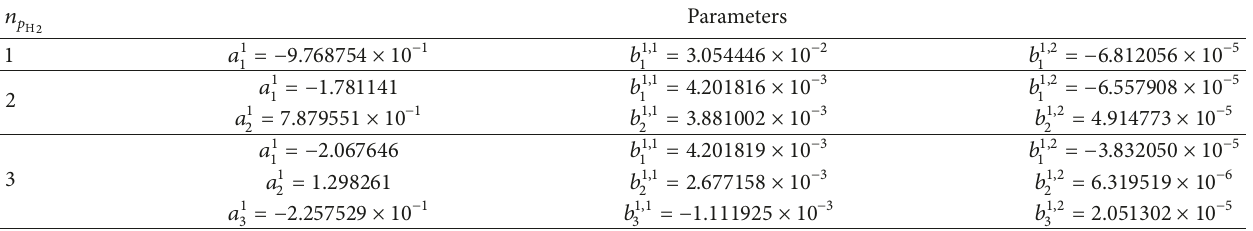
calculated by the first algorithm. H 2